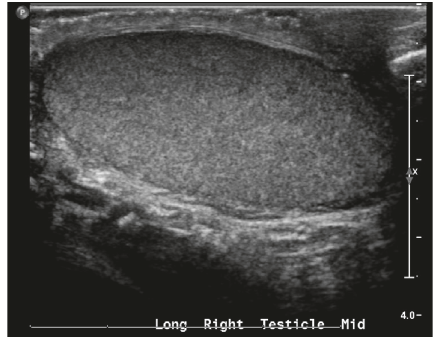
Figure 2: Ultrasound of normal right testicle.